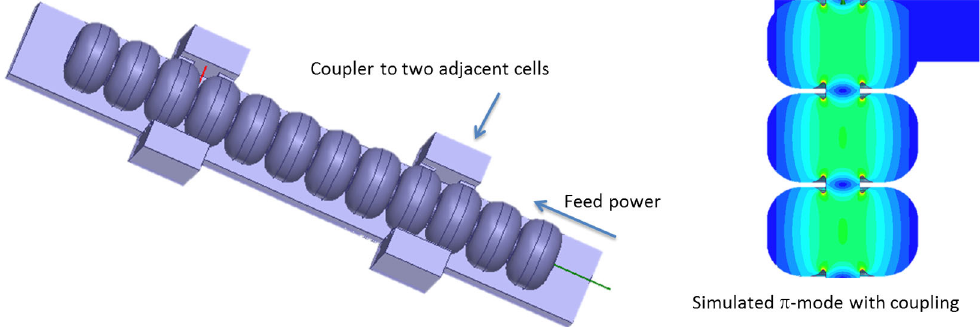
FIG. 22. High efficiency standing-wave linac structure with distributed coupling. Two sections each 10 cm long are shown. Structures would be stacked into a 1.3 m long linac providing approximately 21 MeVenergy gain for 1.6 MW input power. The right side shows π mode with